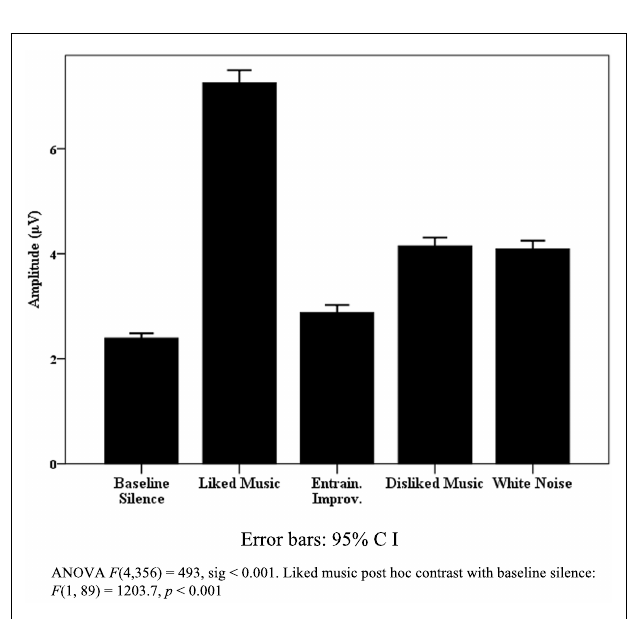
FIGURE 6 | Case “A” right temporal theta and alpha activity .